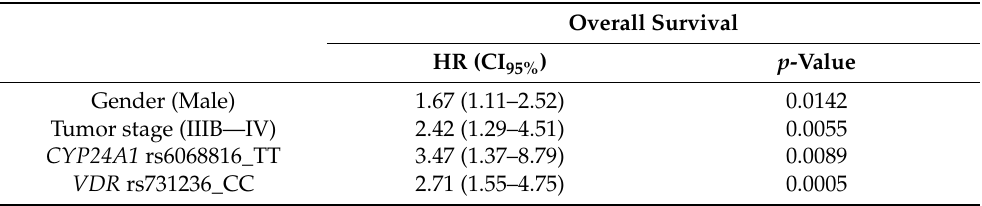
Figure 6. Kaplan–Meier plot of overall survival curves with the T allele of the VDR rs731236 gene polymorphism in the non-resected NSCLC subgroup. Table 6. Influence of gene polymorphisms and clinical characteristic on overall survival of non- resected NSCLC patients.